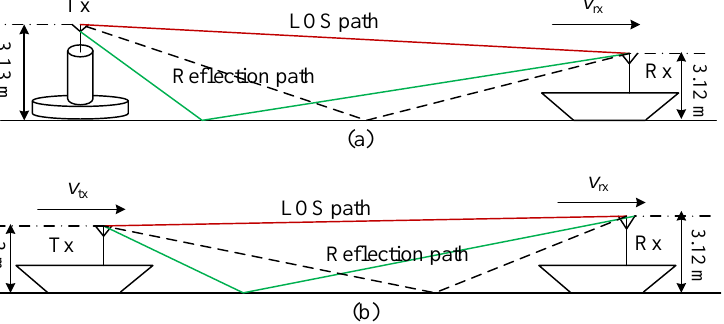
Figure 1. Diagrams of the S2I and S2S measurement campaigns. ( a ) is for S2I and ( b ) is for S2S. During the measurement, the Tx boat anchored on the pontoon over the sea and another boat carrying the Rx part sailed away from the pontoon with an average speed of 8.37 knots (about 15.5 km/h) in the Jiaozhou Bay. The maximum distance between Tx and Rx parts was 1.35 nautical miles (about 2.5